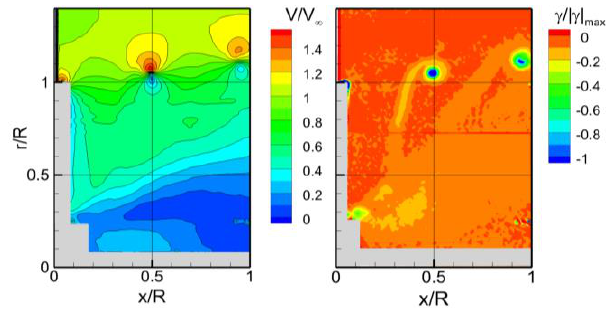
Fig. 2 Average velocity (left) and vorticity field (right),